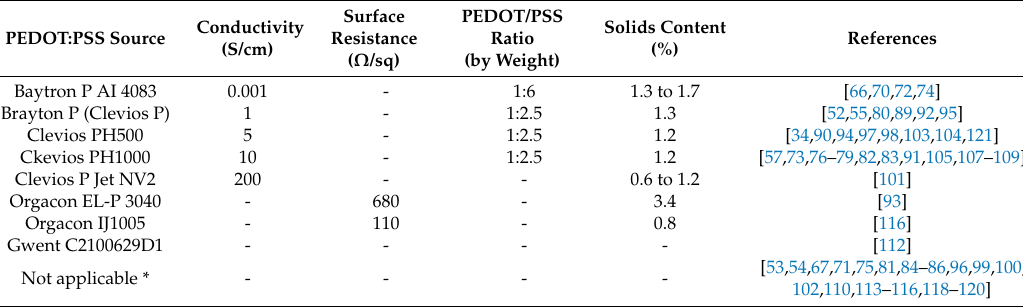
Table 2. Properties of available commercial PEDOT:PSS